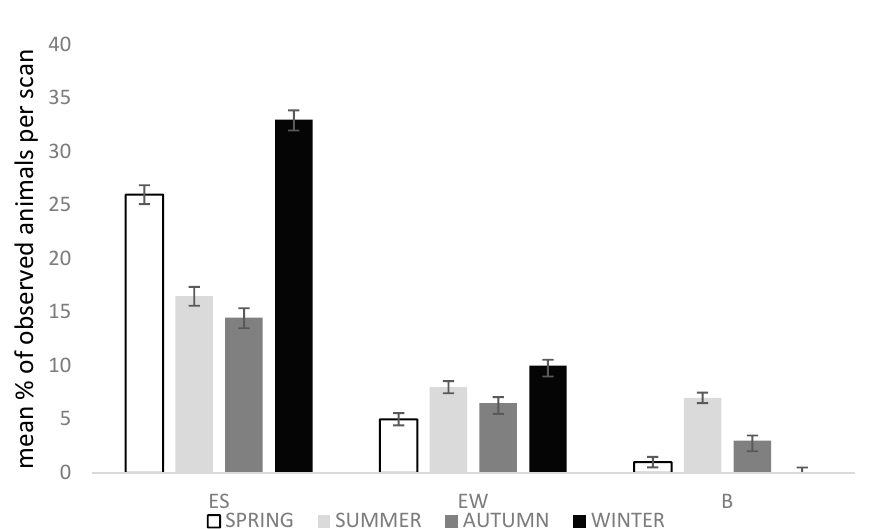
Figure 1. Mean % of observed animals per scan ± Standard Error of the Mean (SEM) of the explore standing (ES), explore walking (EW) and bathing (B) behaviours during the four seasons (spring, summer, autumn, winter) in relation to a total of 1439 observations. Analysed with general models of the Statistical Analysis System (SAS) (Poisson or negative binomial distribution).